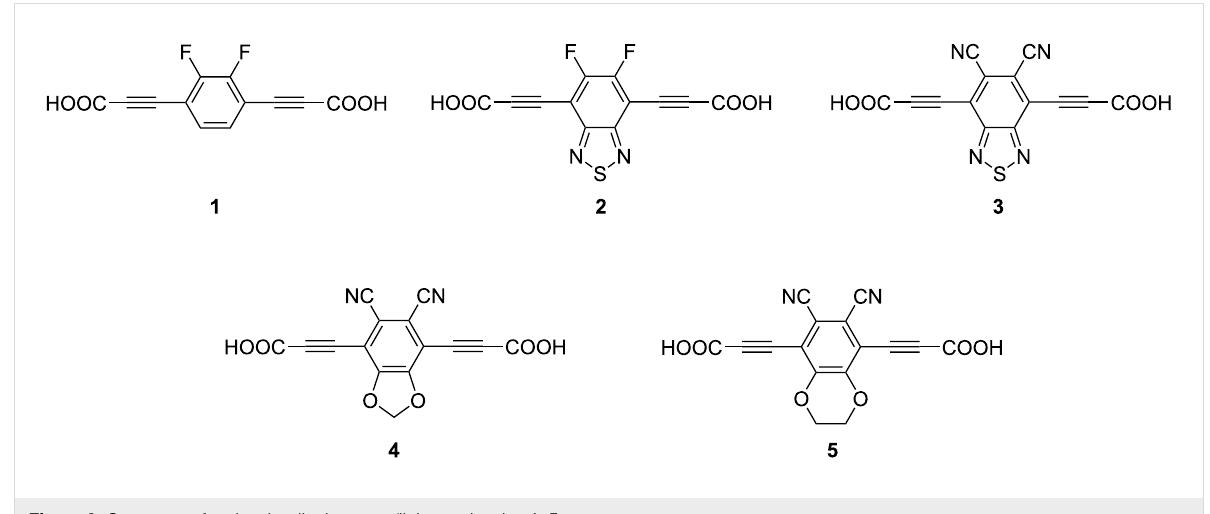
Figure 2: Structures of molecular dipolar rotors/linker molecules 1 – 5